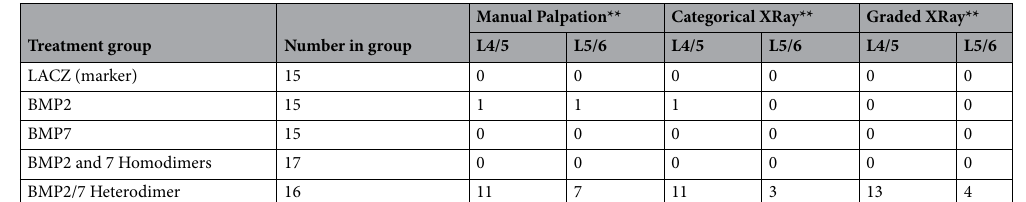
Table 4. Multimodality Fusion Assessments at Lumbar Levels 4/5 (L4/5) and 5/6 (L5/6) 12 Weeks Following Intradiscal Injection of Genetically Programmed Bone Marrow Stromal Cells. *Samples were considered fused if in vivo angular displacement (NIAD) measurement was 3 standard deviations below pre-operative average value. ** Palpation and radiographic fusion was determined as described in Materials and Methods.